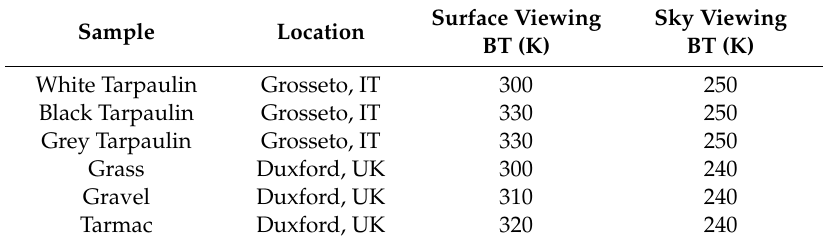
Table 5. Input surface viewing and sky viewing brightness temperatures used to simulate land surface temperature with the measured emissivities. Sample Location